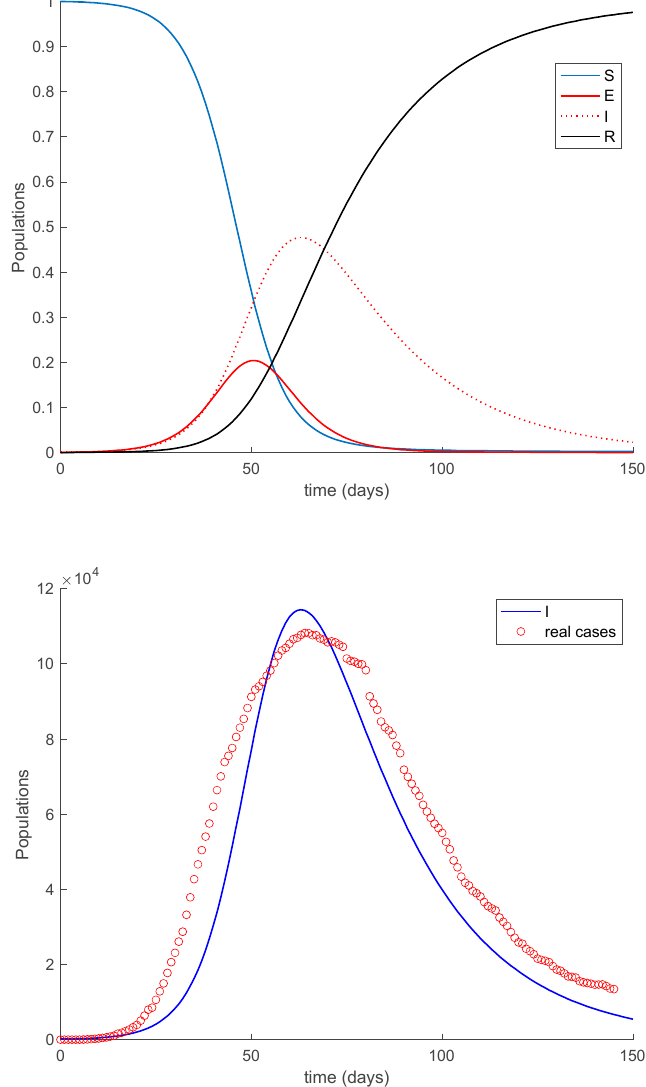
Figure 15. Dynamics of the model for the COVID-19 pandemic in Italy for Case 2.1. In the absence of loss of immunity, all the population becomes immune